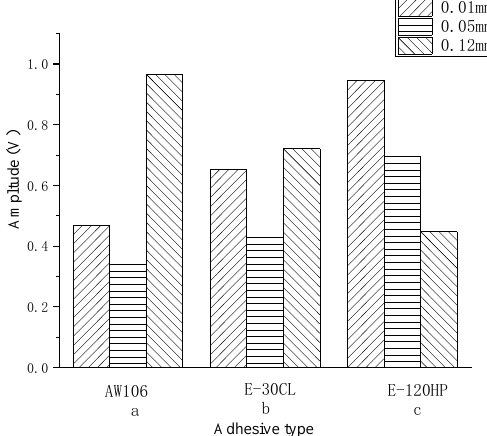
Figure 7. Amplitude extracted from original signal of three kind of thickness: ( a ) the adhesive is AW106; ( b ) the adhesive is E-30CL; ( c ) the adhesive is E-120HP.